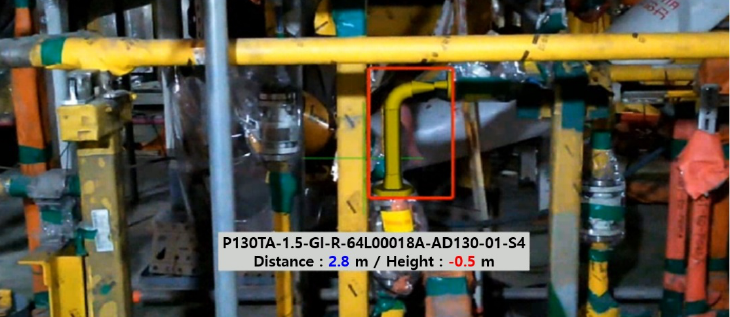
Figure 18. AR-based outfitting detection. Intuitive confirmation is possible with the highlighted box and distance and direction